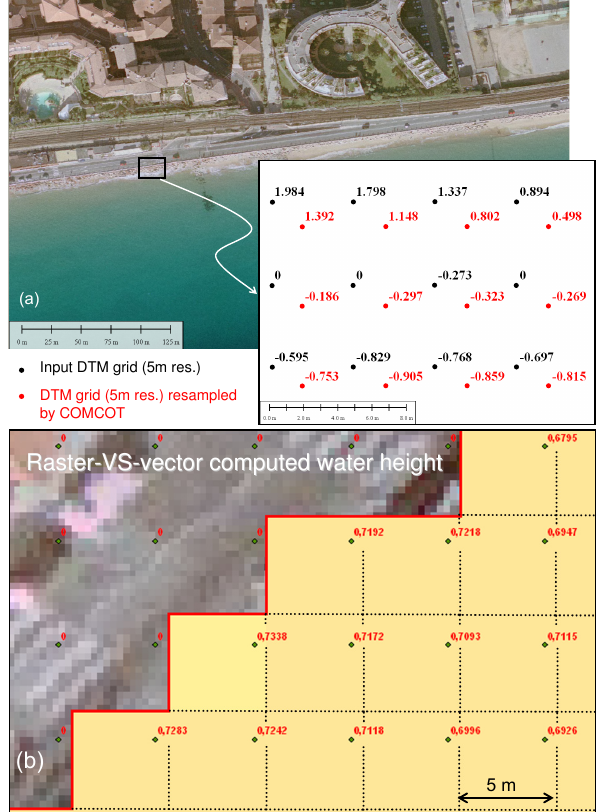
Fig. 7. Two possible representations (under ArcGIS) of the same computed inundation by using two resampling methods: nearest neighbour (A) or bilinear interpolation (B)